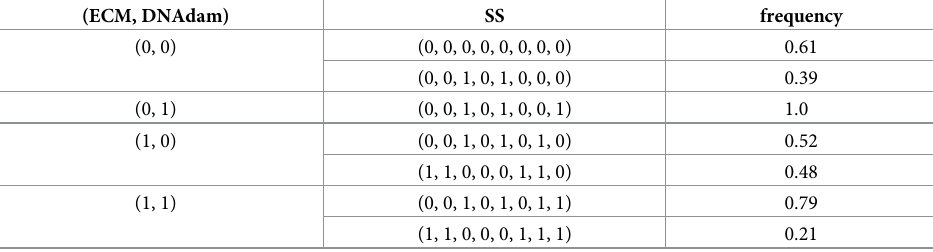
Table 4. Summary of the asynchronous updating results for the EMT model from [55] after 100 asynchronous updating simulations for each of the 256 possible initial states. The order of species is (NICD, Notch, TP53, TP63_TP73, miRNA, EMTreg, ECM, DNAdam). The network splits into four mutually exclusive sub-networks depending on the two parameters ECM and DNAdam. Initial states for three of those sub-networks can run into two different attractors with varying frequency. (ECM, DNAdam)